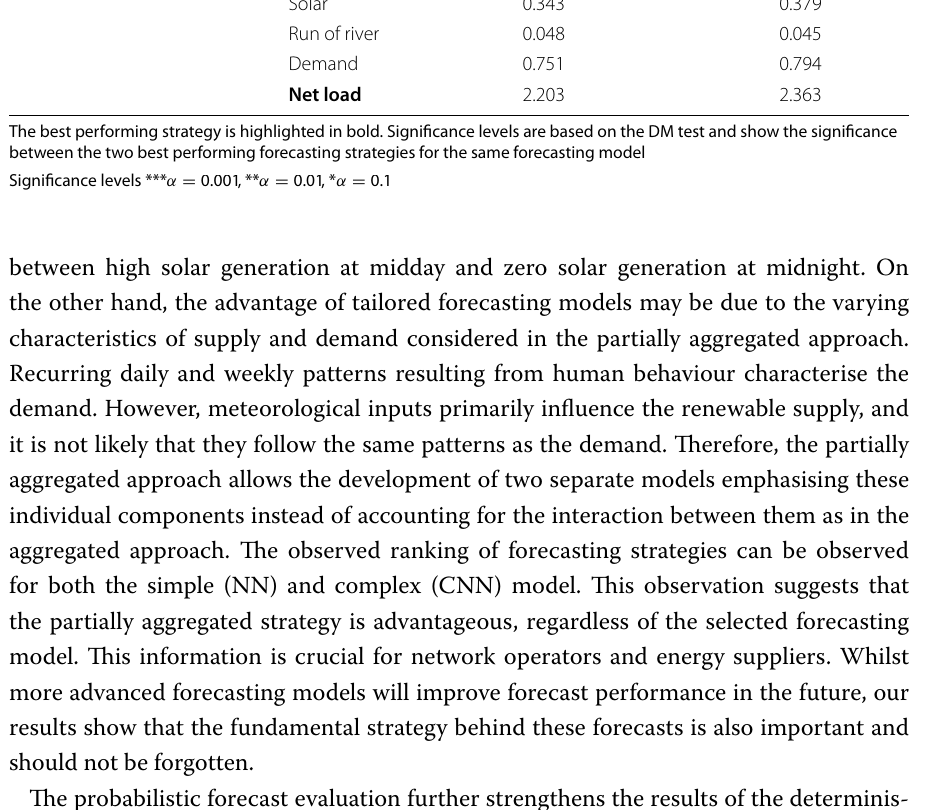
The best performing strategy is highlighted in bold. Significance levels are based on the DM test and show the significance between the two best performing forecasting strategies for the same forecasting model Significance levels *** α = 0.001 , ** α = 0.01 , * α =